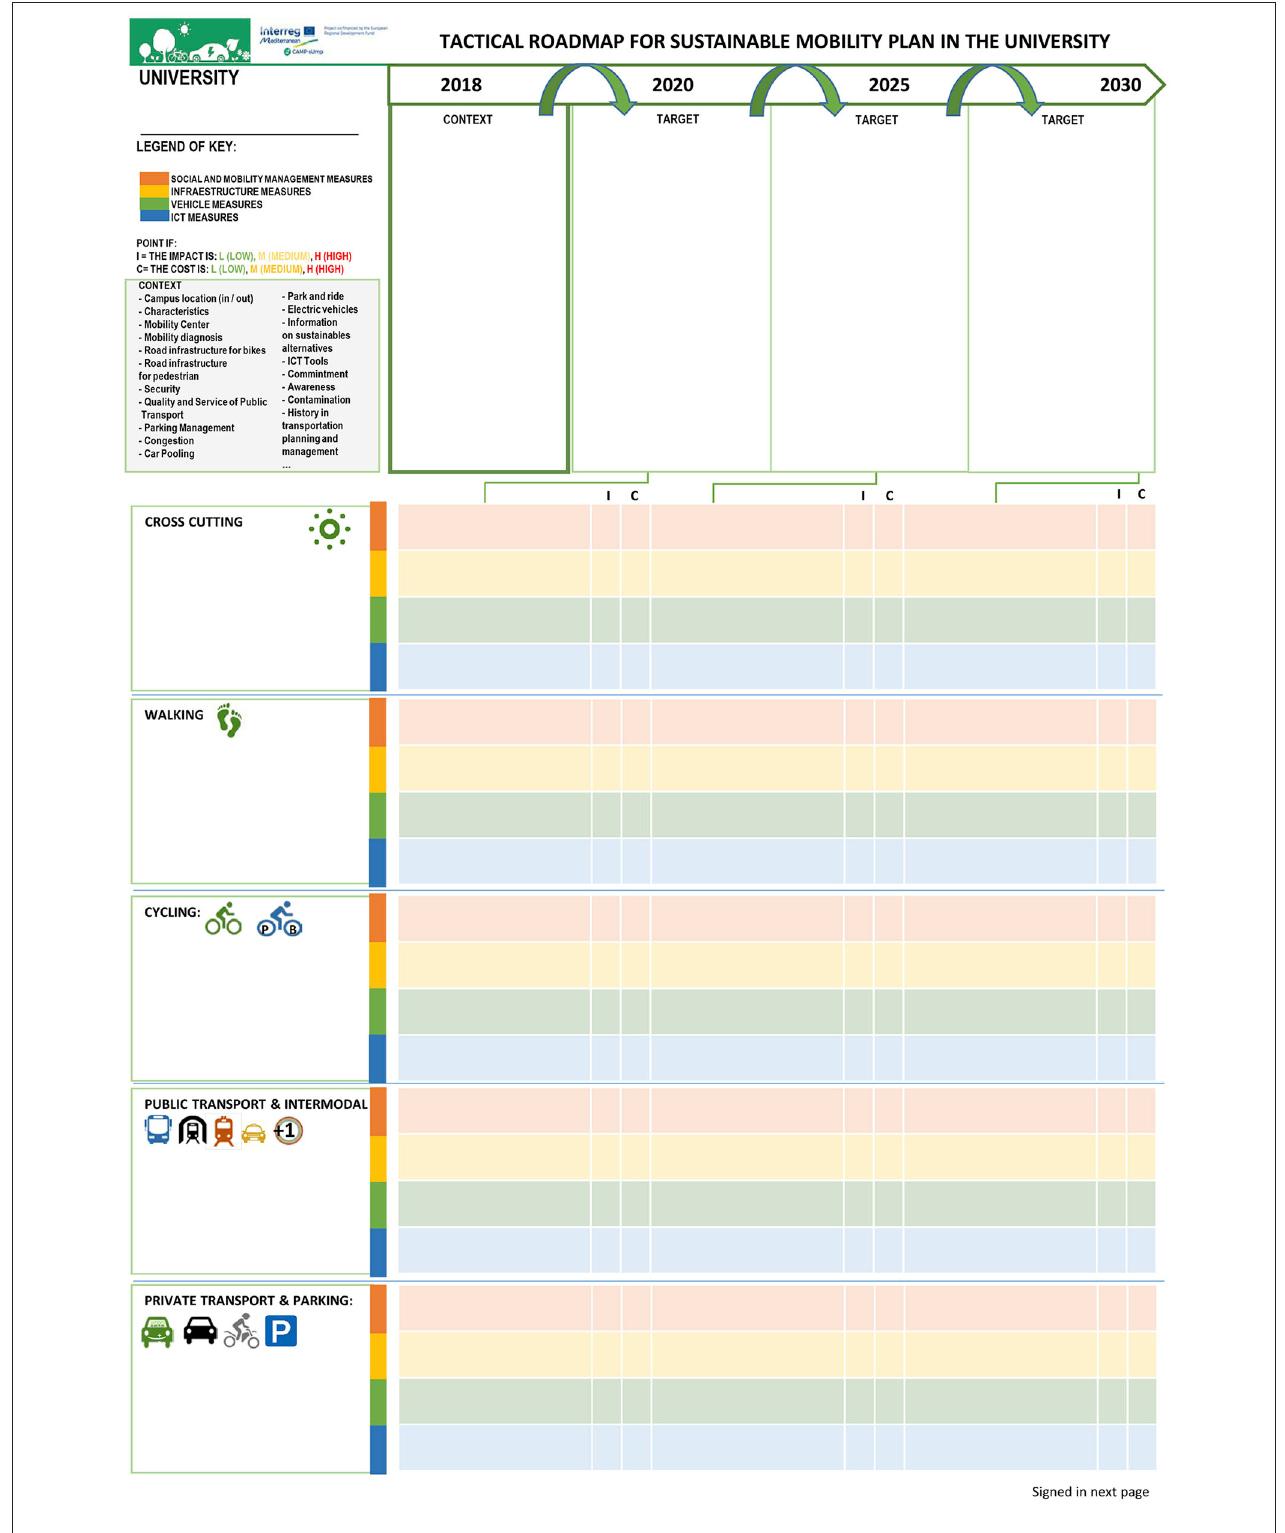
FIGURE 2 | Template of the tactical roadmap (Extracted from Deliverable 3.5.1 CAMP-sUmp Project, Tormo Lancero et al., 2018).